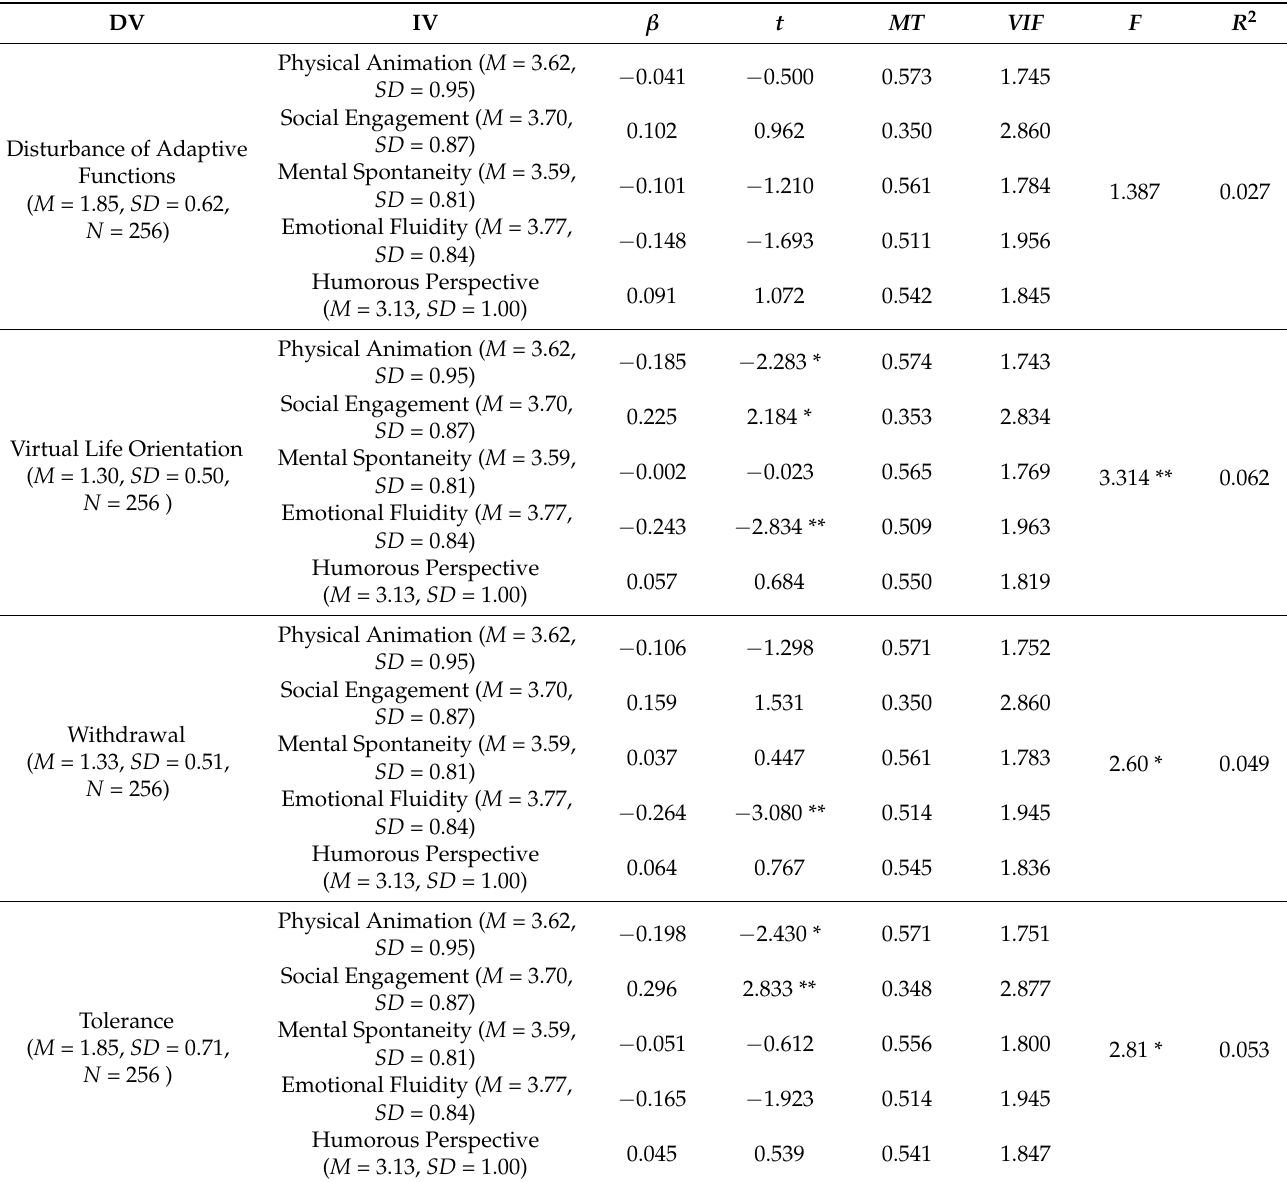
Table 3. Multiple Regression Analysis of Playfulness and Smartphone